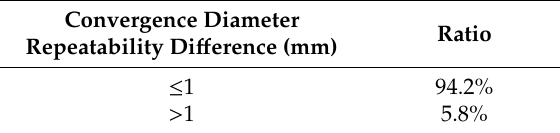
Figure 9. Dislocation of the forward and backward measurements.